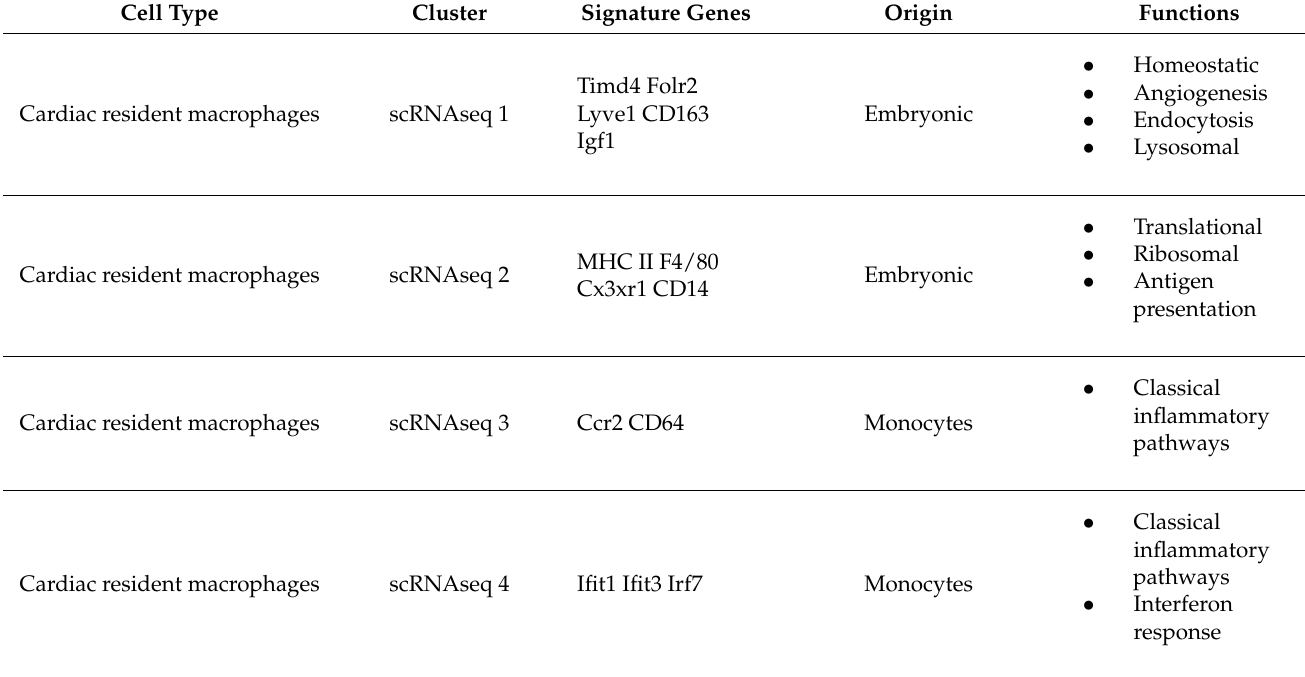
Table 2. Cardiac-resident macrophage clusters in homeostasis by transcriptomic